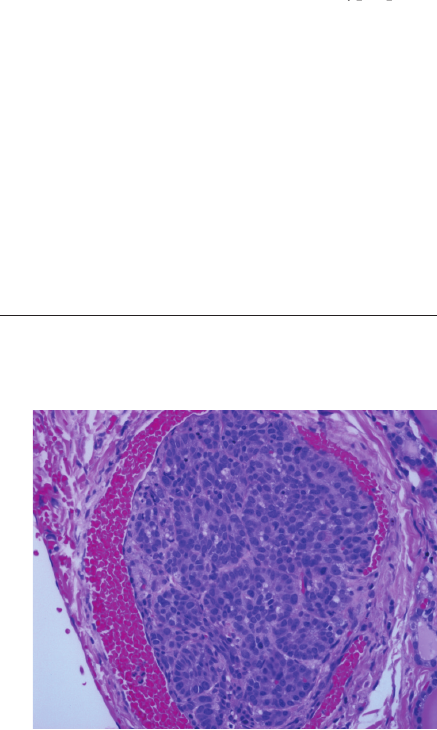
Figure 2: H&E stain × 400. Intravascular tumor adjacent to the right thyroid lobe nodule consistent with the diagnosis of intrathyroidal metastasis from a primary laryngeal neuroendocrine